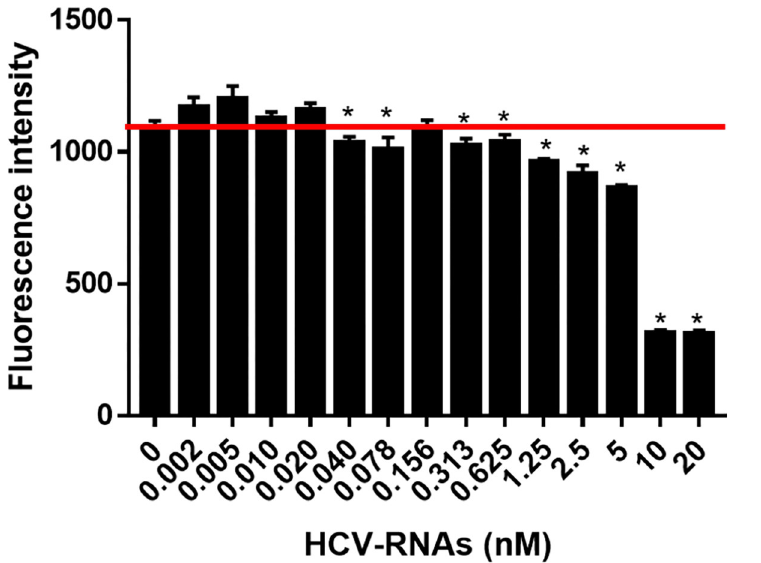
Fig 4. Detection of the HCV-RNAs. � p < 0.05 vs. blank control, n = 3.